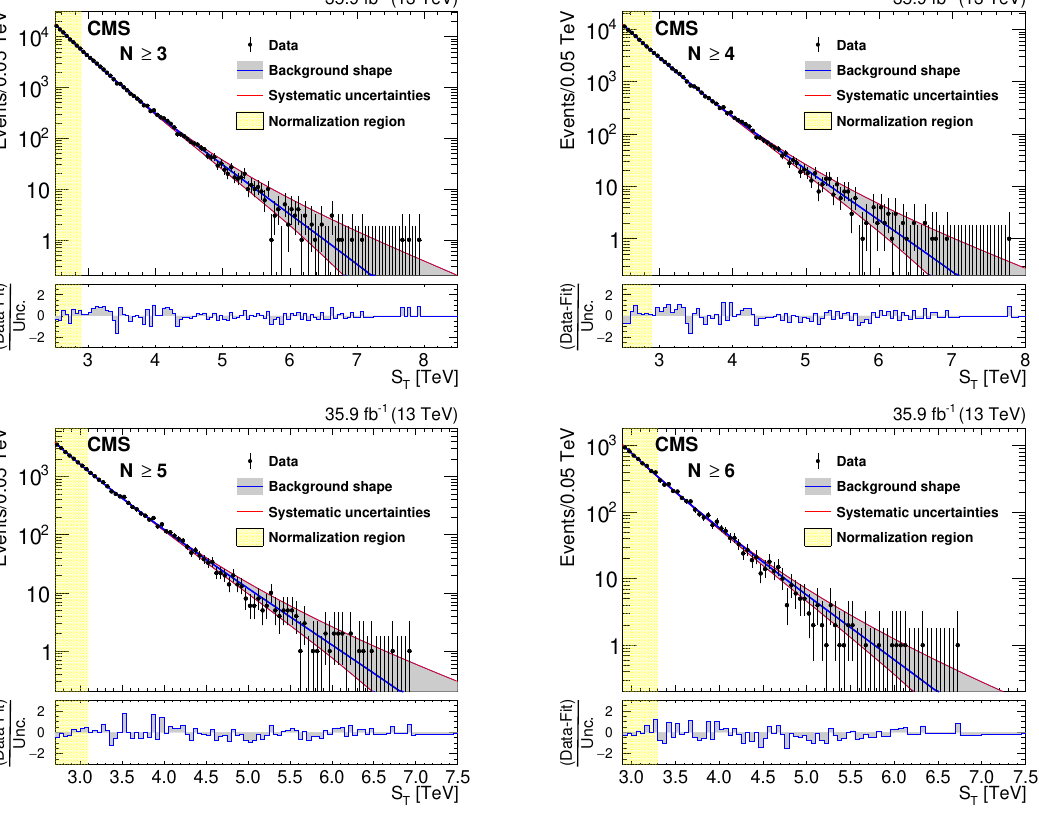
Figure 4 . The comparison of data and the background predictions after the normalization for inclusive multiplicities N (cid:21) 3 ; : : : ; 6 (left to right, upper to lower). The gray band shows the background shape uncertainty alone and the red lines also include the normalization uncertainty. The bottom panels show the di(cid:11)erence between the data and the background prediction from the (cid:12)t, divided by the overall uncertainty, which includes the statistical uncertainty of data as well as the shape and normalization uncertainties in the background prediction, added in